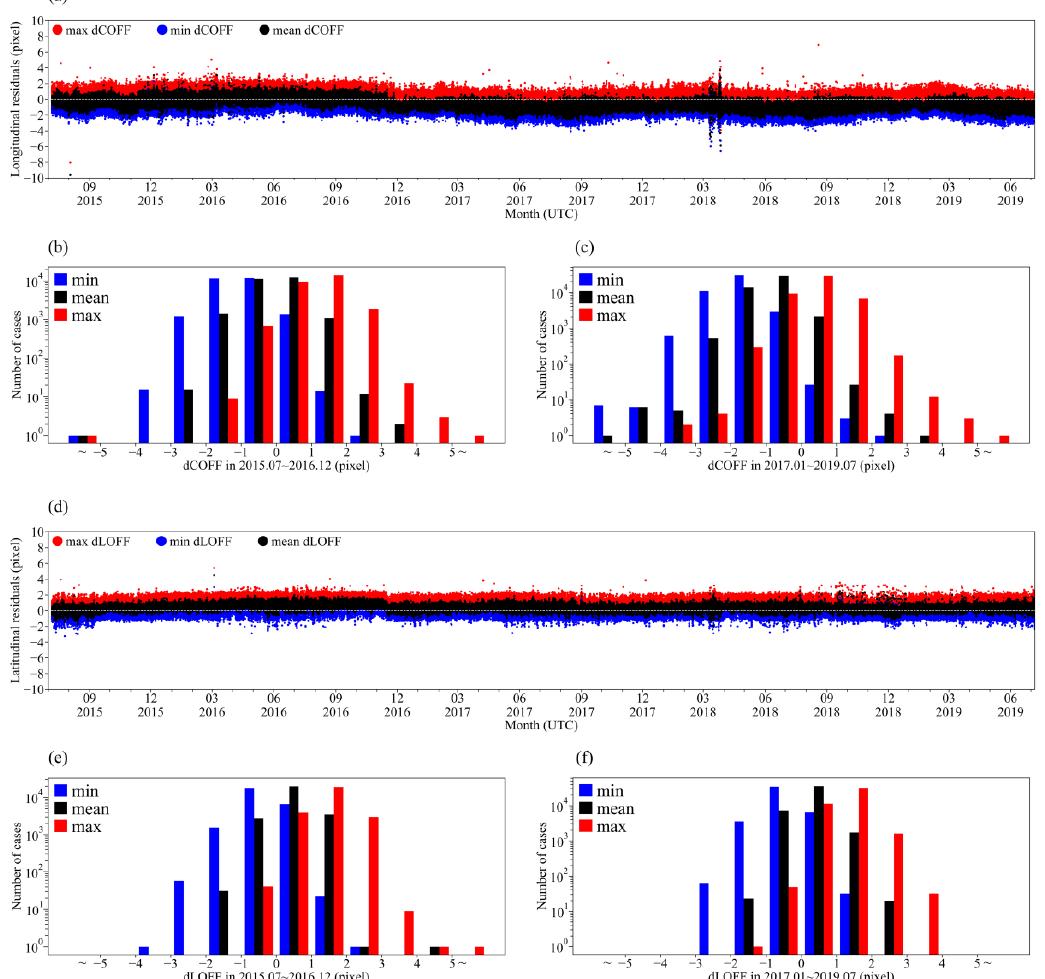
Figure 4. (a) Time series of the maximum, mean, and minimum values of COFF differences (dCOFF) for all 22,000 scans taken every 10 min as part of both JMA and CEReS data. Histograms show the (e), and (f) show the same data as Figure 4 (a), (b) and (c), respectively, but for the dLOFF.